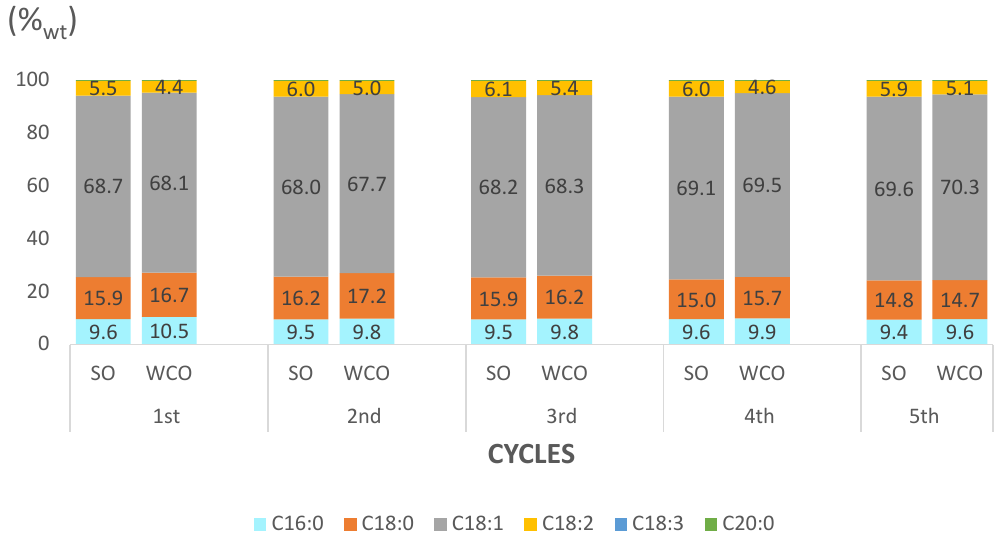
Figure 6. SO and WCO FAMEs compositions (% wt ) after each of the five subsequent runs with the same Ni-pol catalyst. Reaction conditions: SO or WCO biodiesels (125 mg), Ni-pol (0.059 mmol of Ni), and CH 3 OH (5 mL), at 100 ◦ C, H 2 (10 bar), and t = 10 h. In all of the histograms, the percent of C20:0 methyl ester is equal to 0.3%.